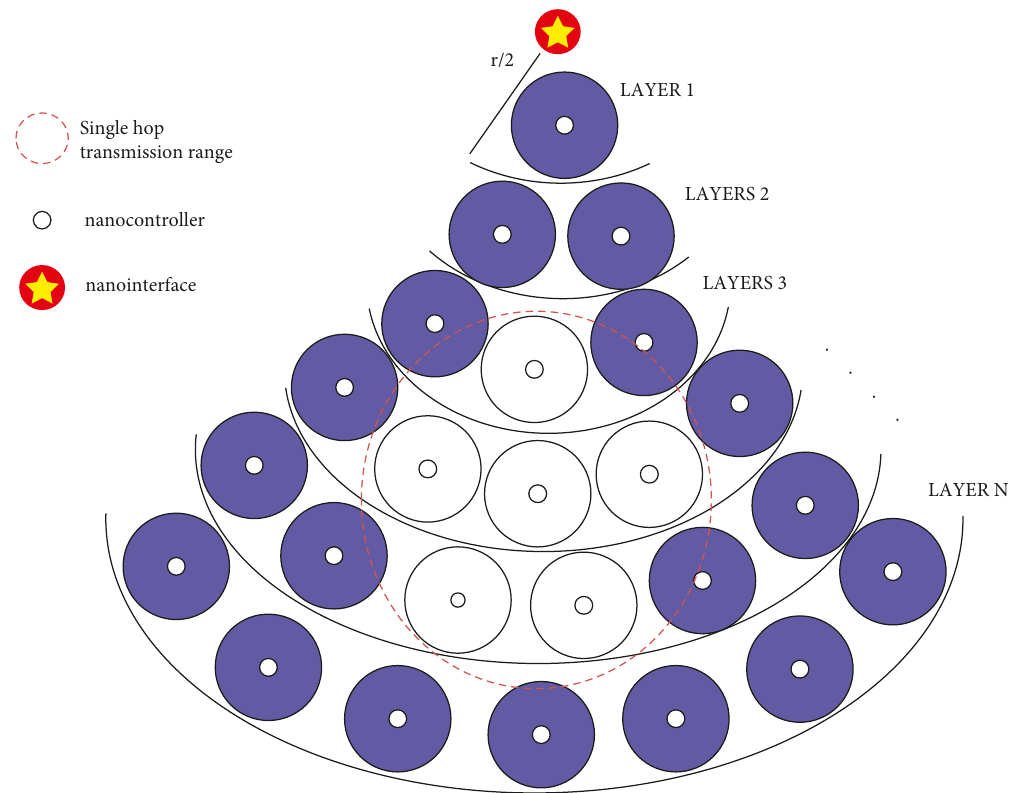
Figure 3: Layering architecture of